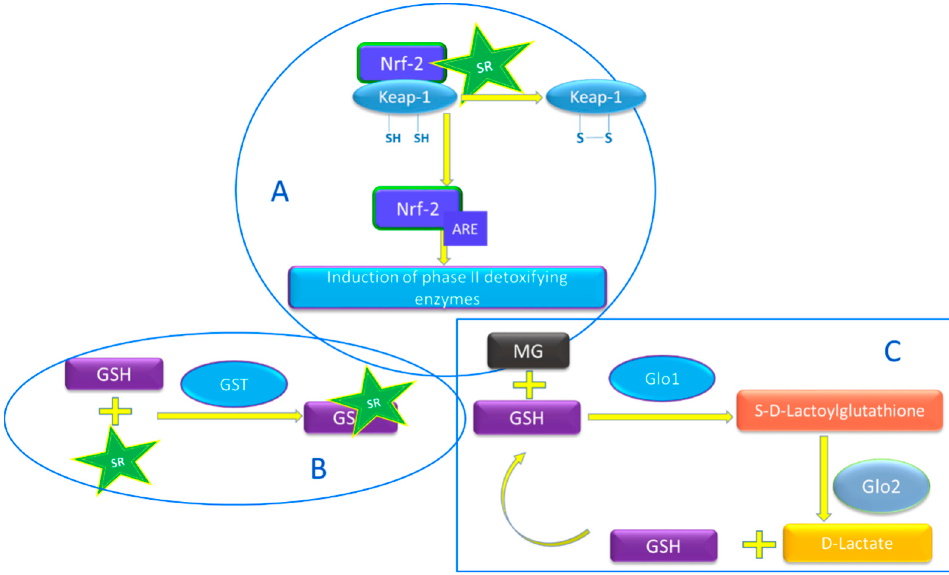
Figure 1. ( A ) Schematic representation of the potential effect of sulforaphane (SR) on phase II enzymes. SR can interact with cysteine residues of Kelch-like ECH-associated protein 1 (Keap1), causing dissociation of Keap1 from the transcription factor NF-E2-related factor 2 (Nrf2), allowing Nrf2 translocation to the nucleus and gene activation through the antioxidant response element (ARE) which are situated upstream of the promoter region of the genes of many antioxidant and phase II biotransformation enzymes, among those glyoxalase 1 (Glo1) and glutathione S-transferases (GST) [6,7]. ( B ) Schematic representation of the GST action [7,8]. It catalyzes the conjugation of GSH with xenobiotic compounds for detoxification, in this case SR. ( C ) Schematic representation of the glyoxalase system. Glyoxalase 1 (Glo1) catalyzes the formation of S-2-hydroxyacylglutathione from hemithioacetal which forms non-enzymatically from reduced glutathione (GSH) and α -oxoaldehyde methylglyoxal (MGO) [9,10]. Glyoxalase 2 (Glo2) catalyzes the hydrolysis of S -2-hydroxyacylglutathione to the corresponding aldonic acid, regenerating GSH that is consumed in the Glo1-catalysed reaction [9,10].